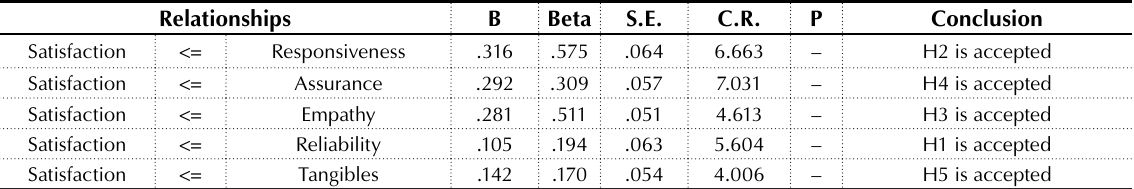
Table 5. Regression coefficients of the formal research model